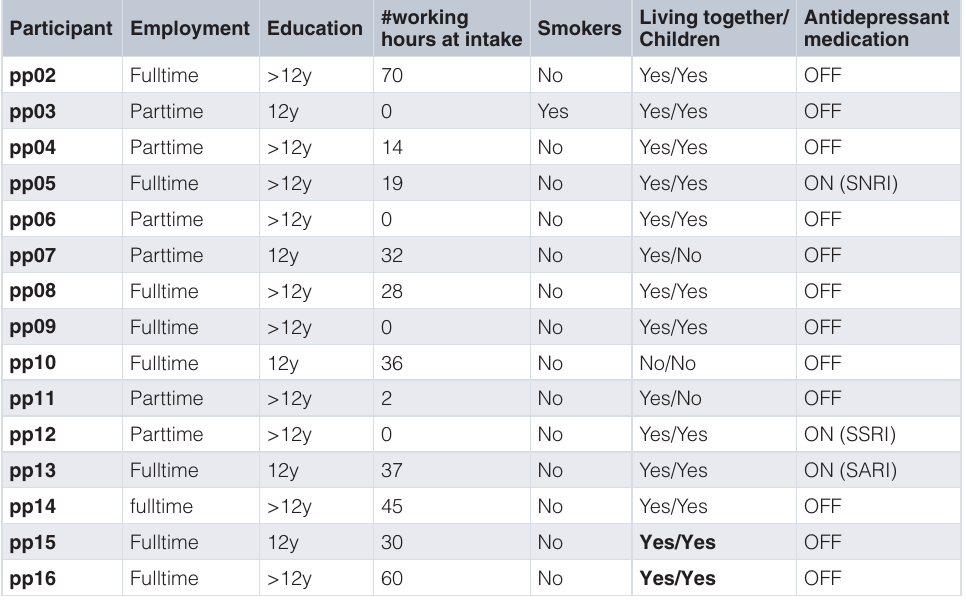
#working Living together/ Antidepressant Smokers hours at intake Children medication